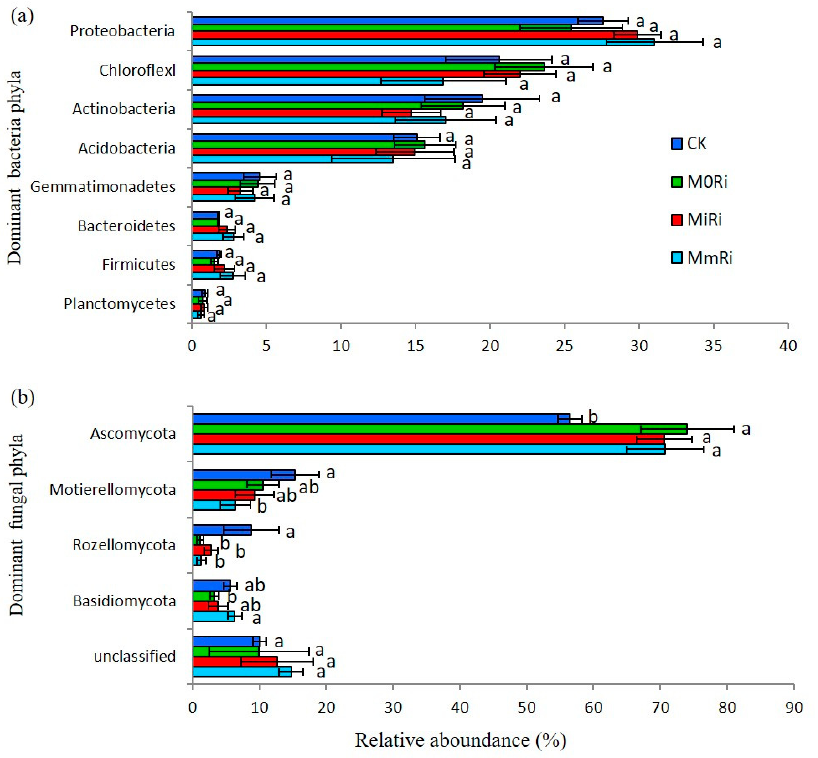
Figure 2. Relative abundance ( n = 3) of the dominant bacterial and fungal phyla in di ff erent straw-return treatments. Relative abundances are based on the proportional frequencies of the DNA sequences that could be classified at the phylum level. We selected the top eight abundant bacteria and top five abundant fungal phyla to show in the bar chart. ( a ) Relative abundance of the dominant bacteria phyla in di ff erent straw-return treatments. ( b ) Relative abundance of the fungal phyla in di ff erent straw-return treatments. Error bars indicate the standard deviation of the mean.